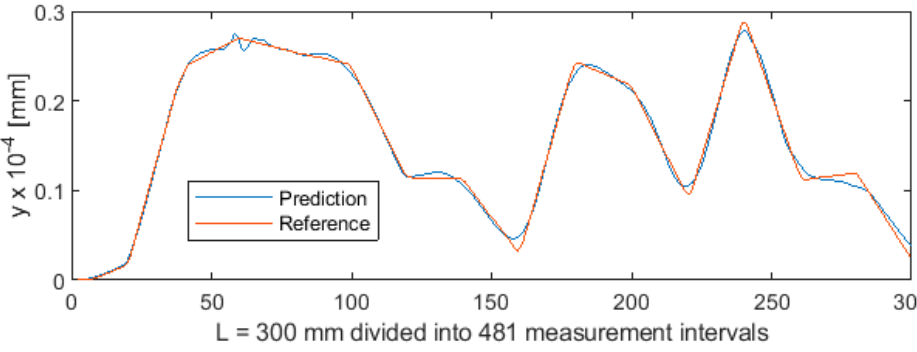
Figure 19. Machining quality prediction using MLP ANN.